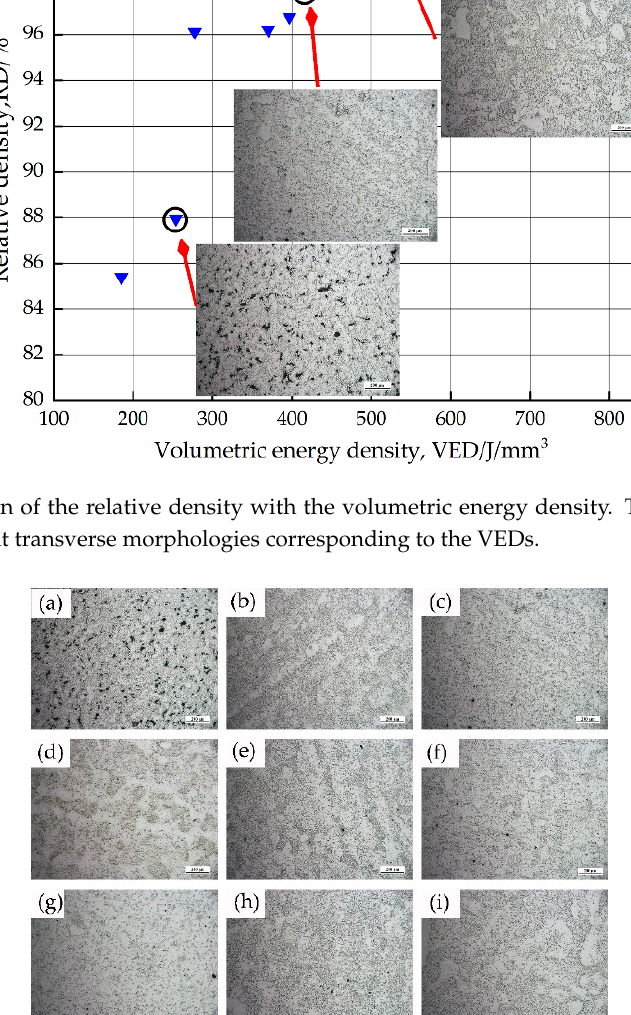
Figure 8. Transverse morphology with a high magnification. ( a ) 253.97 J/mm 3 ; ( b ) 648.15 J/mm 3 . The pores were nearly fully filled with the formed liquid phase. A combination of high laser power (350 W) and low scan speed (150 mm/s) produced a longer residence time for the liquid phase. Therefore, the best rearrangement characteristics for the tungsten powder particles were observed under the capillary force of liquid, and the densification of samples was improved. When the laser